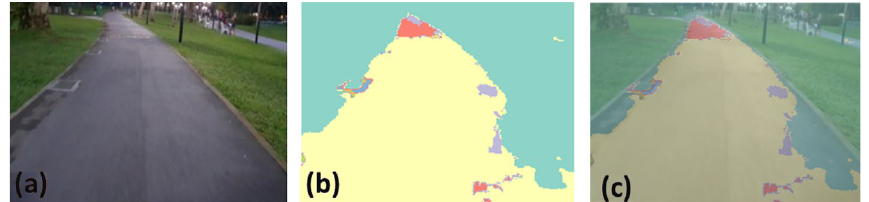
Figure 35. Unet segmentation results: pavement with night mode.